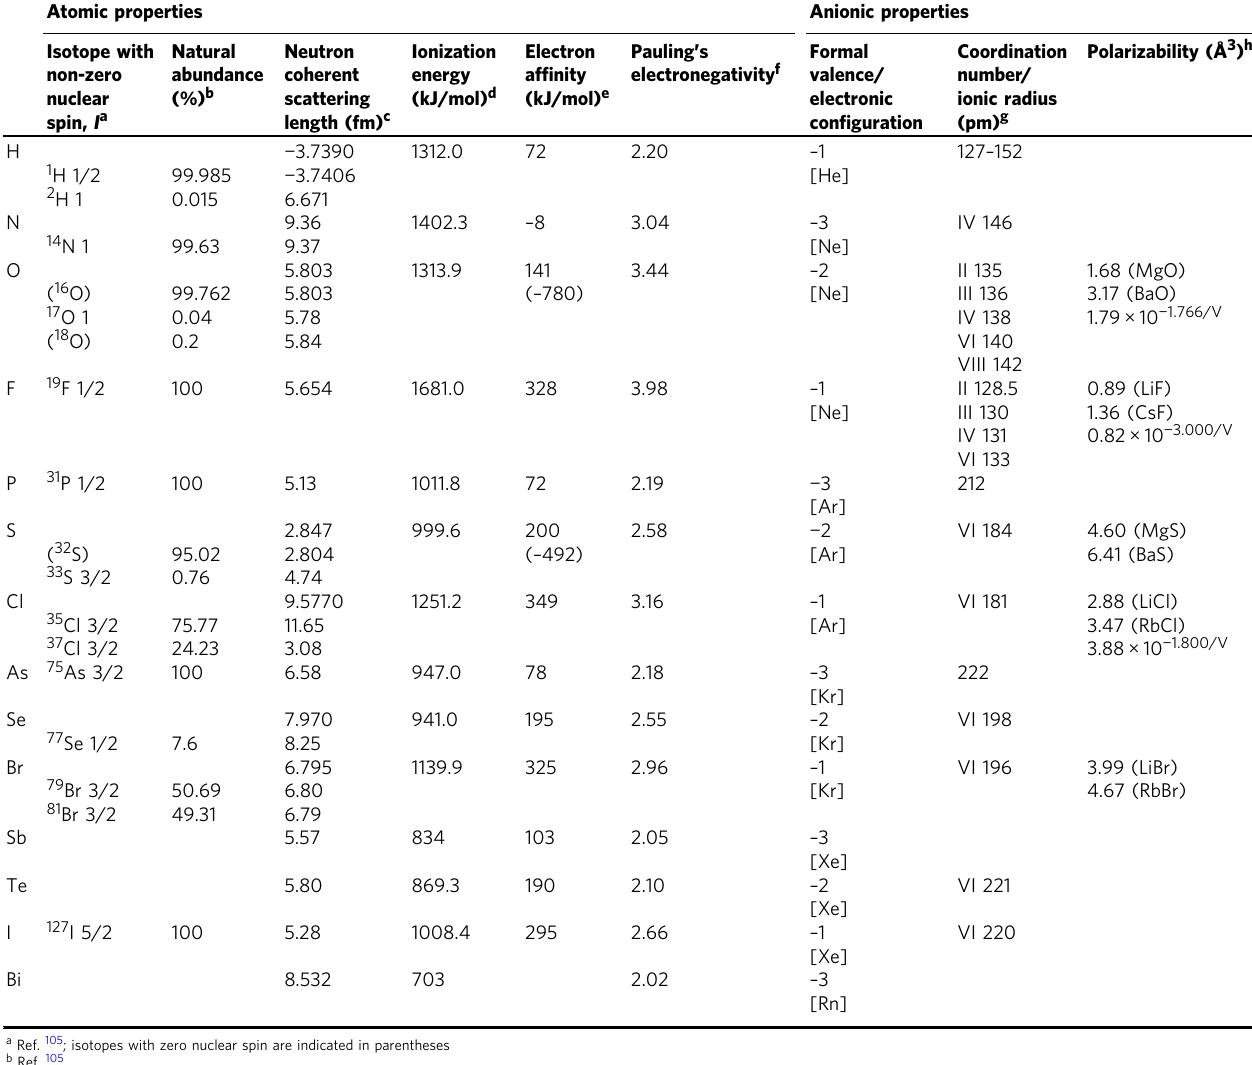
Table 1 Basic parameters of anions-forming elements and their ions